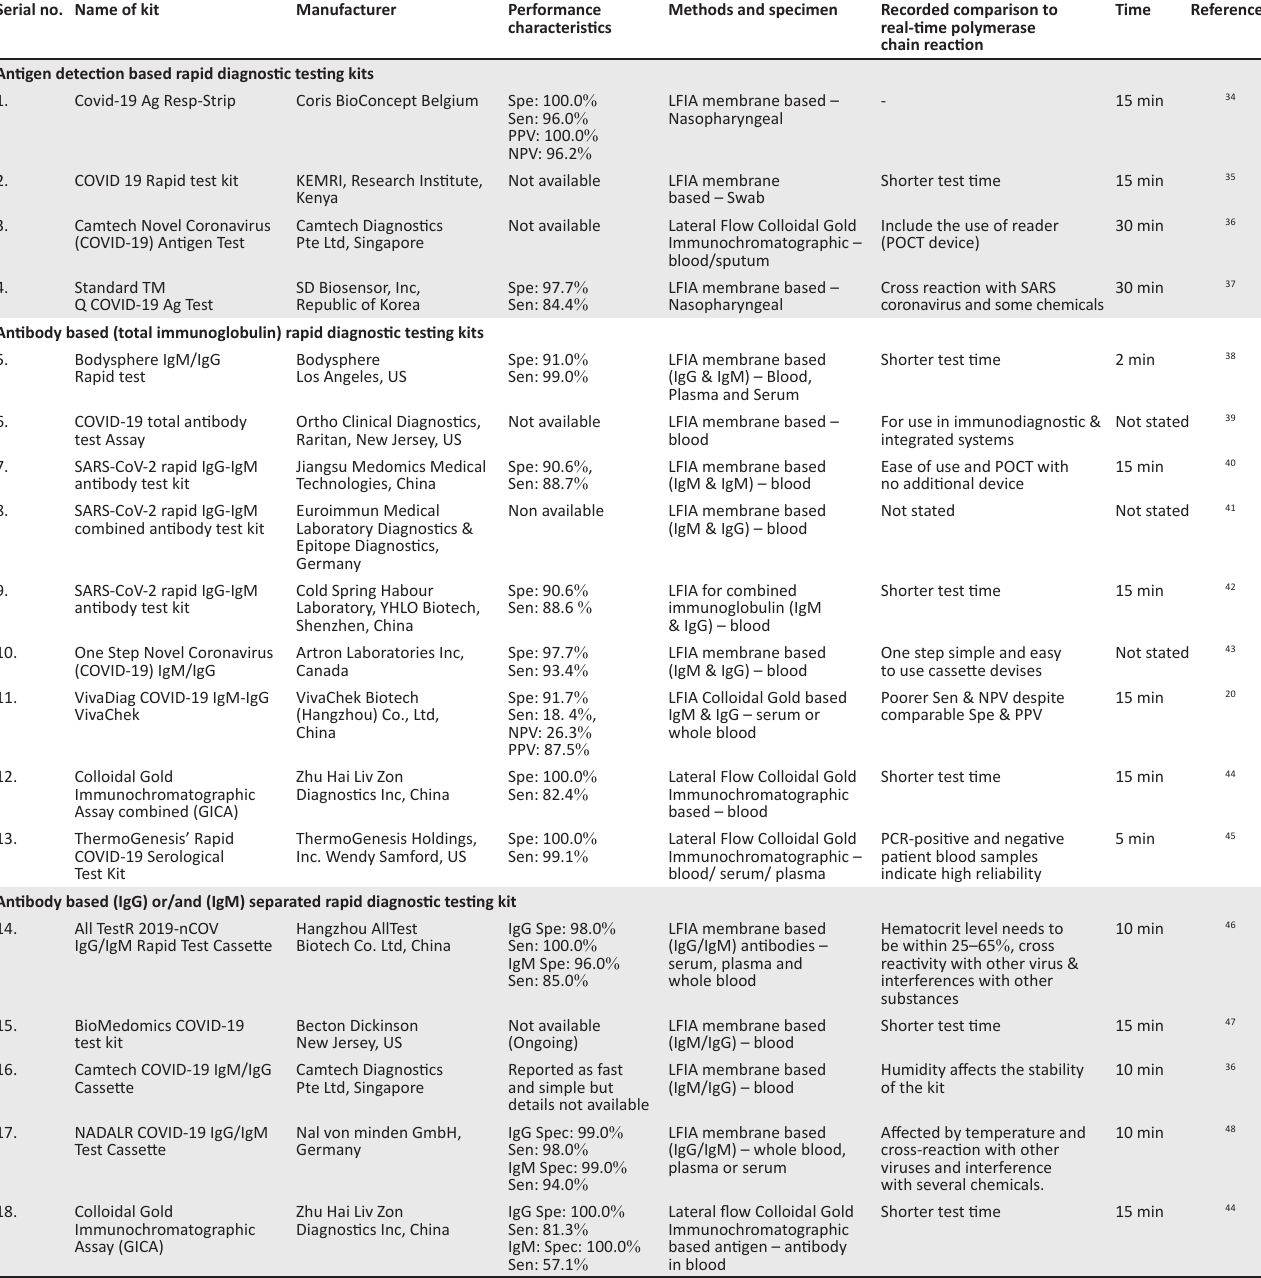
TABLE 1: Performance characteristics of newly developed severe acute respiratory syndrome coronavirus rapid diagnostic kits analysed in this review, 22 April 2020. Serial no. Name of